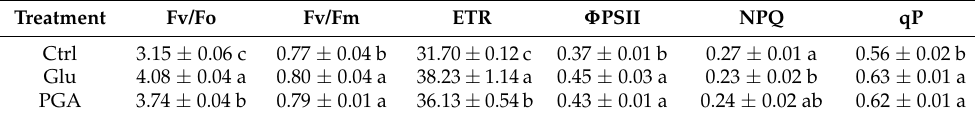
Table 4. Effects of Glu and γ -PGA on chlorophyll fluorescence parameters in Chinese cabbage under heat